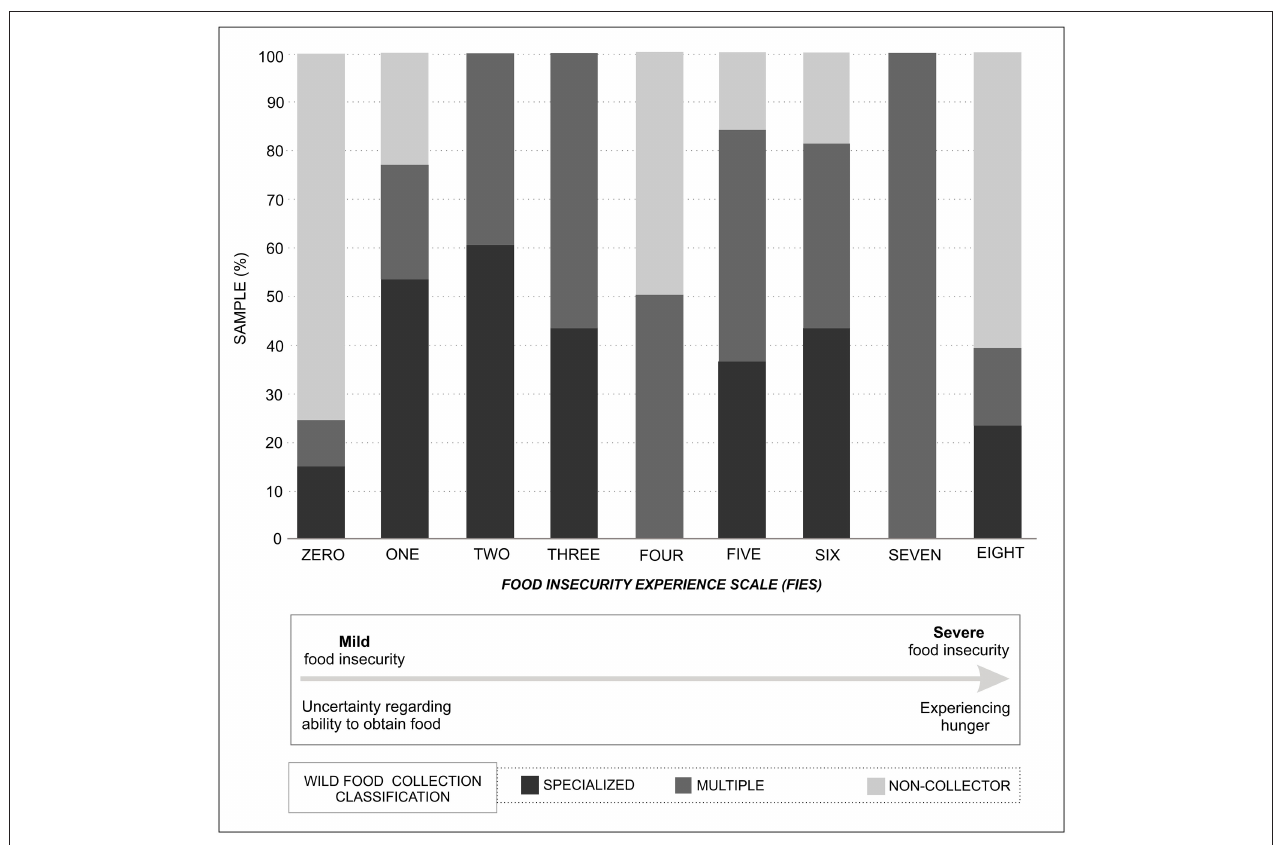
FIGURE 3 | Food Insecurity Experience Scale (FIES) and wild food harvest.